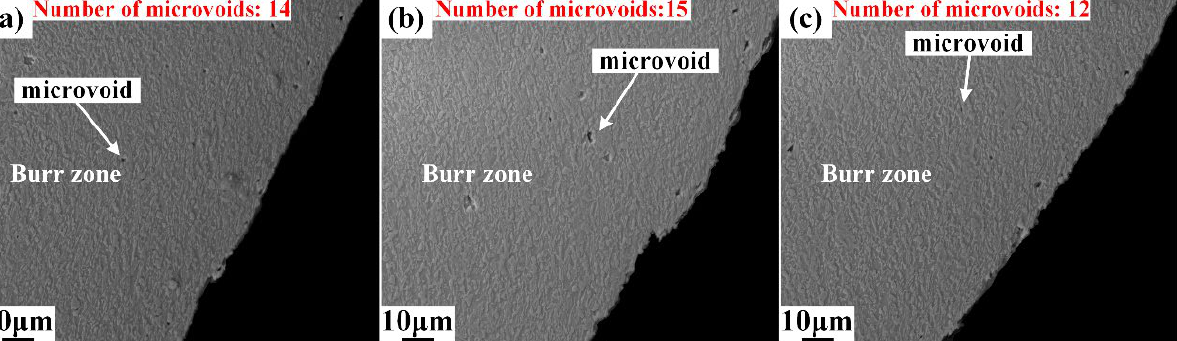
Figure 13. Microstructure of sheared edge in area V obtained under different shearing clearances: